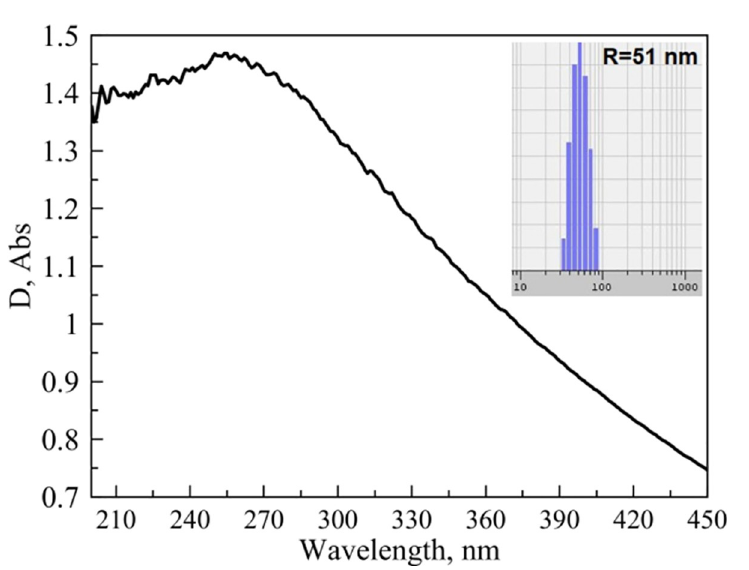
Fig 5. Pt NPs plasmon absorption band and NPs size distribution (inset).